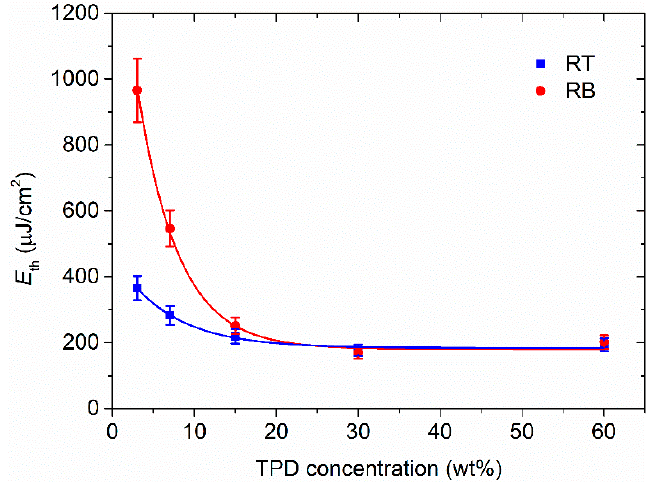
Figure 5. Thresholds of DFB lasers based on TPD for RB and RT configurations.